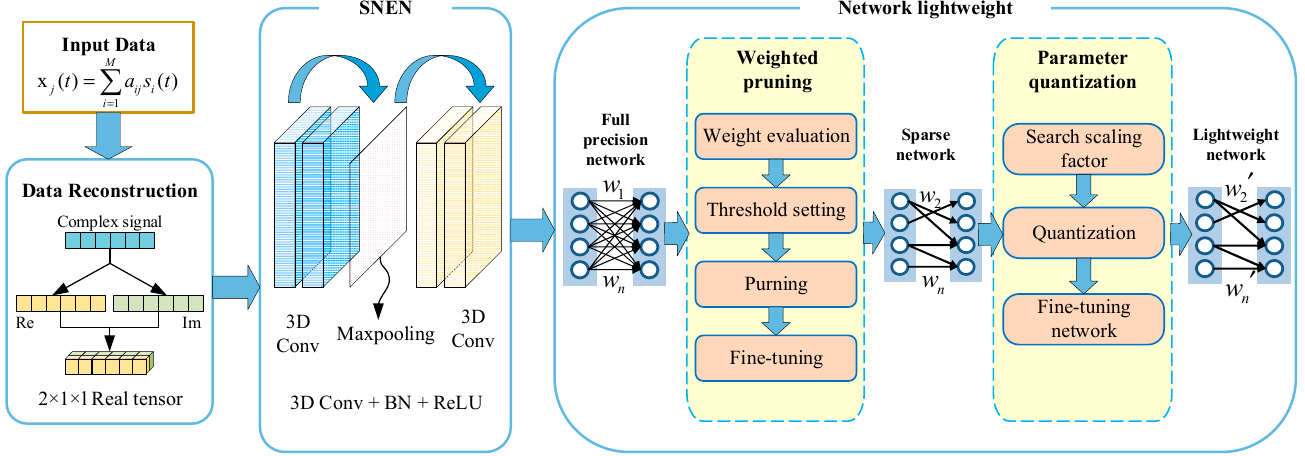
Figure 1. Lightweight source number estimation network flow. Table 2. Symbols and their brief description/definition in Section 3.